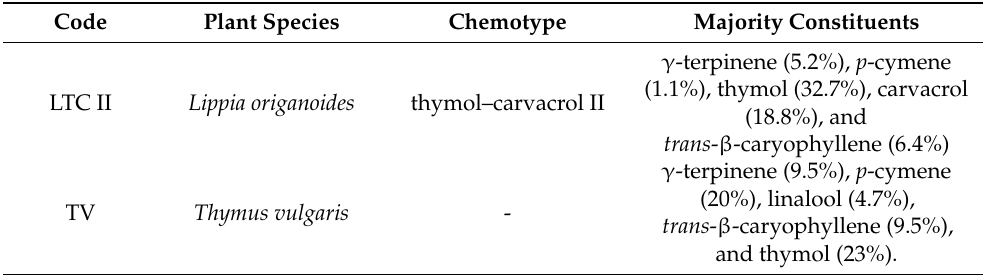
Table 1. Main compounds present in the EOs that showed the highest antibacterial and antibiofilm activities, expressed in relative quantity